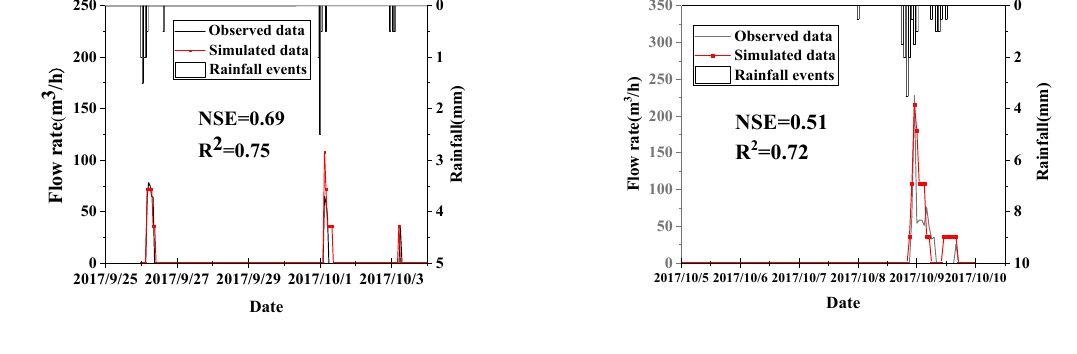
Figure 6. Comparisons between observed and simulated runoff data.